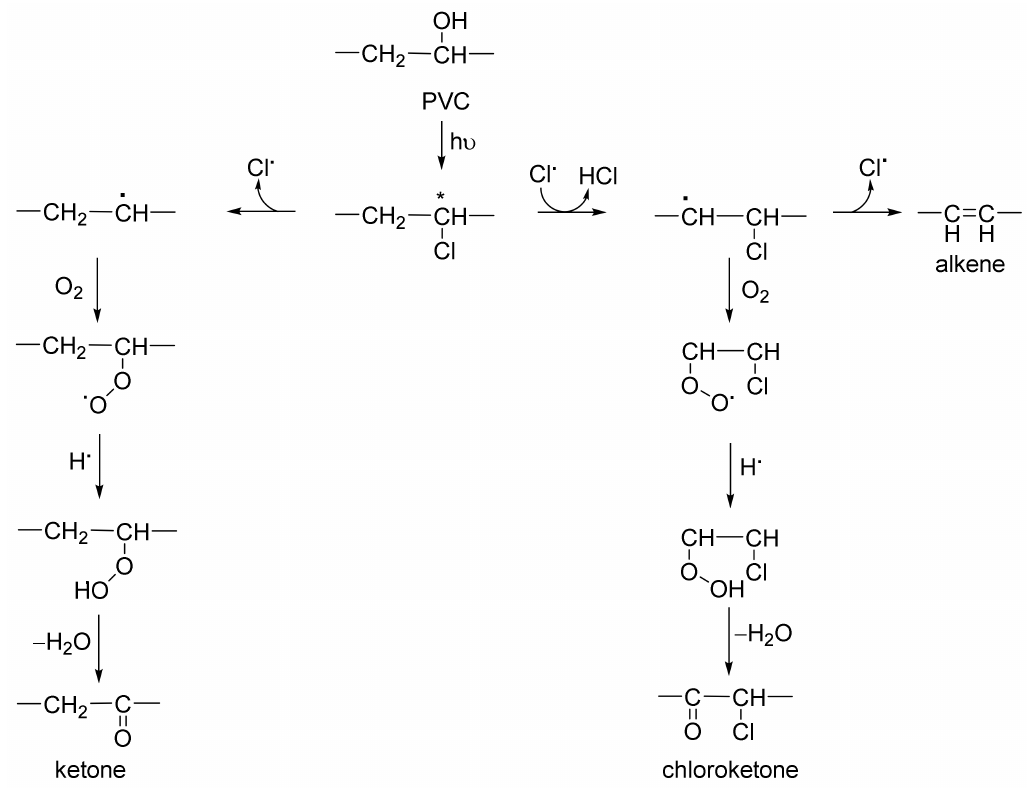
Figure 4. Photooxidation of PVC. *: Excited